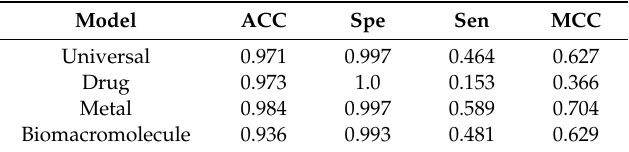
Table 3. Performance of the membrane protein-ligand binding site predictor (MPLs-Pred) on the training dataset with the universal model and ligand-specific models over 10-fold cross-validation.